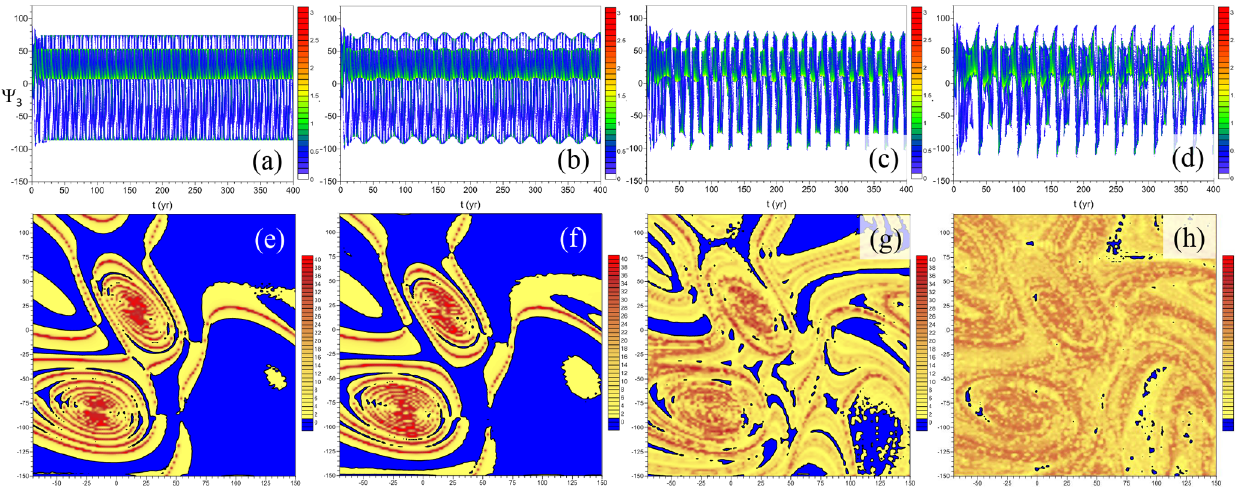
Figure 6. Transition from a periodic to a chaotic PBA as the amplitude ε of the periodic forcing in Eq. (3) increases. (a–d) Time evolution of P (cid:57) 3 and (e–h) maps of σ in the ((cid:57) 1 ,(cid:57) 3 ) plane for γ = 1 . 1, T p = 30 years and ε = 0 , 0 . 05 , 0 . 1 and 0 . 2, respectively. Panels (d) and (h) correspond to the reference case studied by Pierini (2014).